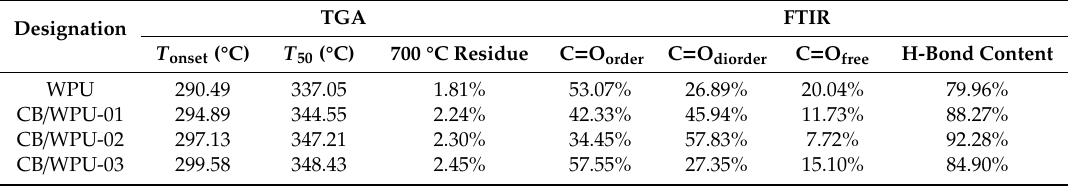
Table 2. Thermal properties and FTIR results of the CB /